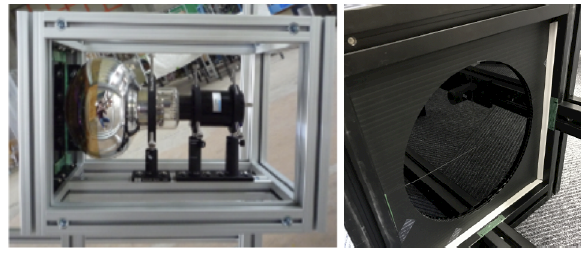
Figure 2. 8 in. PMT with UV transmitting filter. For the proto- type, the